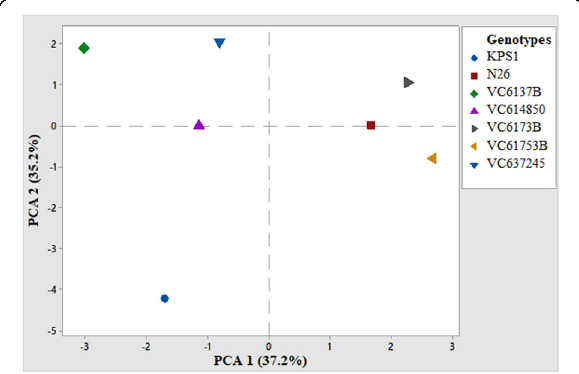
Fig. 2 Principal component analysis (PCA) of mung bean genotypes based on phenotypic traits. The first two components had a variation of (1) 35.6% and (2)